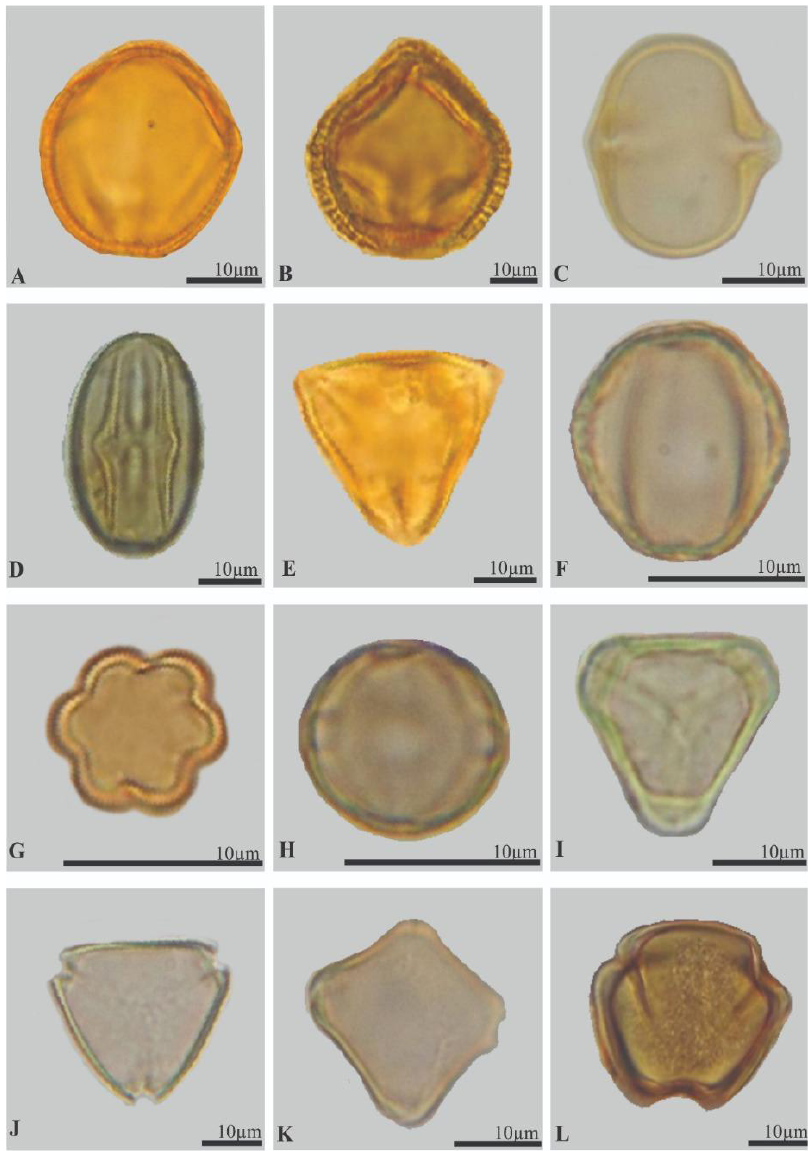
Fig 2 . Photomicrographs of the most frequent pollen types found in honey samples of Melipona seminigra. Anacardiaceae, Spondias mombin (A); Araliaceae, Schefflera morototoni (B); Burseraceae, Protium heptaphyllum (C); Fabaceae, Cassia and Copaifera (D, E); Melastomataceae, Bellucia (F), Miconia (G) and Mouriri (H); Myrtaceae, Eugenia (I), Myrcia (J) and Psidium (K); Solanaceae, Solanum